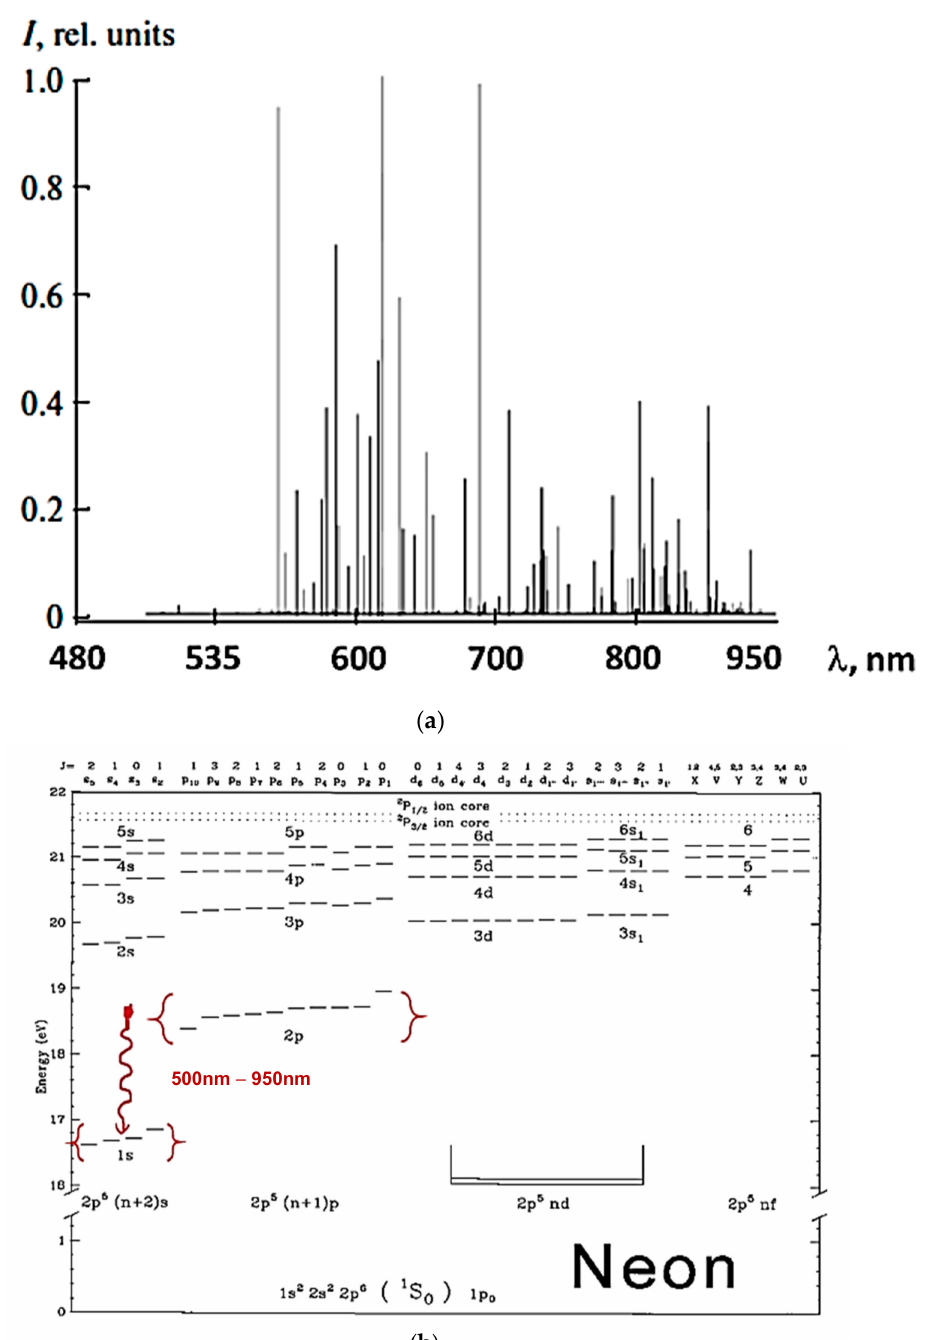
Figure 2. Typical measured spectral emission of neon lamp ( a ) and energy levels of neon. The radiated transitions are marked in red ( b )